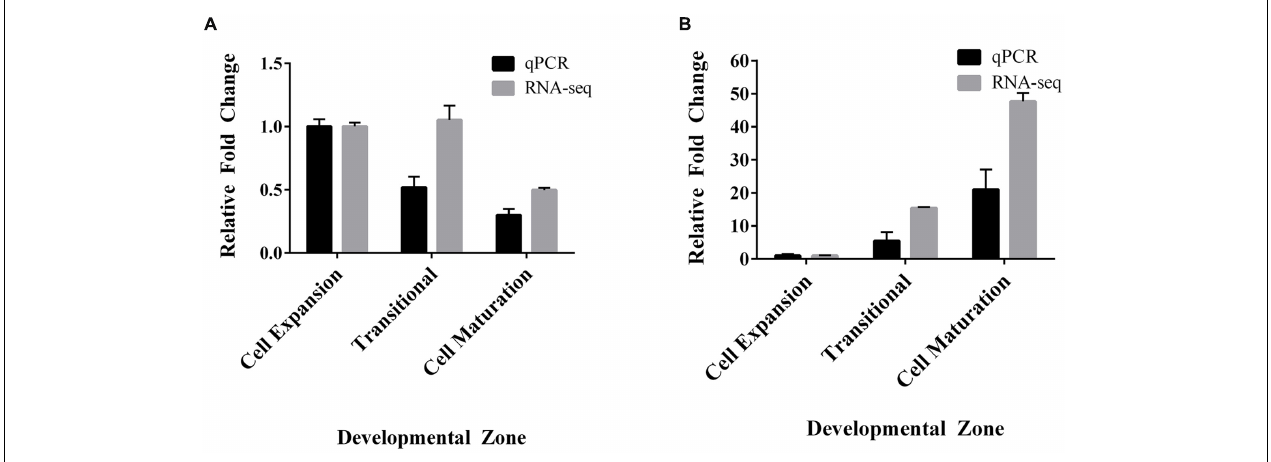
FIGURE 3 | Comparison of relative fold changes between RNA-seq and RT-qPCR of SvPIP2;1 and SvNIP2;2 in an elongating internode of S. viridis. (A) SvPIP2;1 . (B) SvNIP2;2 . Data is mean relative fold change in expression ± SEM. Data for RNA-seq and RT-qPCR was normalized relative to the cell expansion zone expression